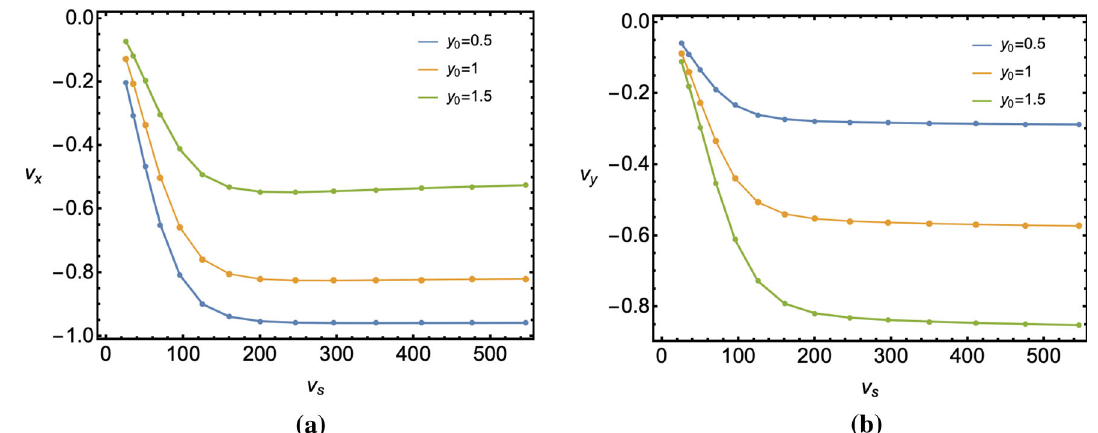
Fig. 8 The apparent velocity as a function of v s , measured in a remote observer. The parameter of the bubble read R = 2, v s = 20 c , and σ = 10. The center of the bubble is placed at x = 0 at start. Figure 7a shows the x component of the velocity of the dust particle at the center minus the speed of the bubble as a function of v s , with initial position of the particle to be x = 2 . 5 and y 0 = 0 . 5, 1 . 0, 1 . 5 respectively. Figure 7b